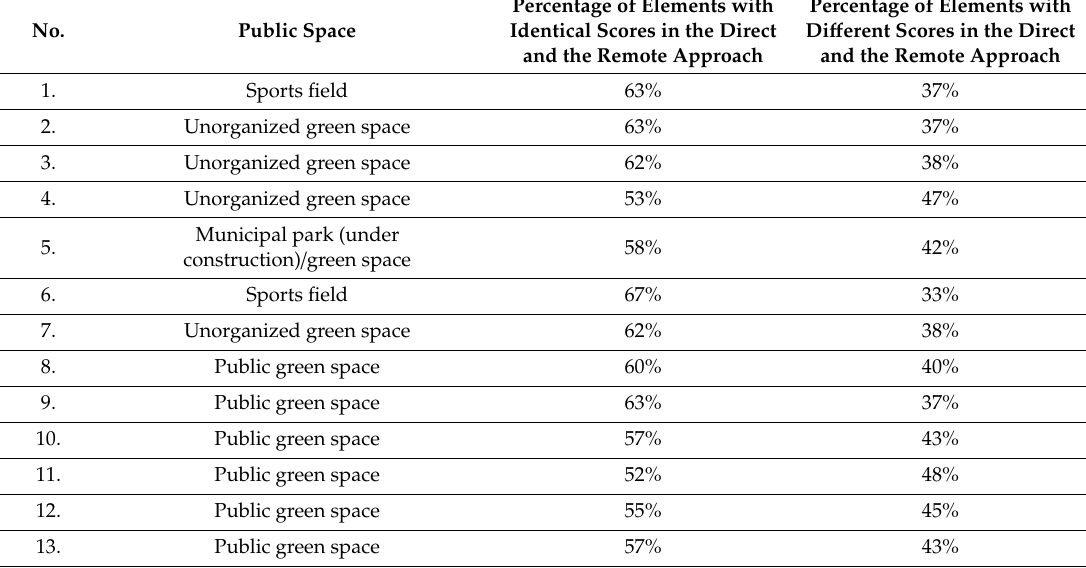
Table 6. The quality of public spaces in Orneta—similarities and di ff erences in the results generated by the direct and the remote approach. Source: own